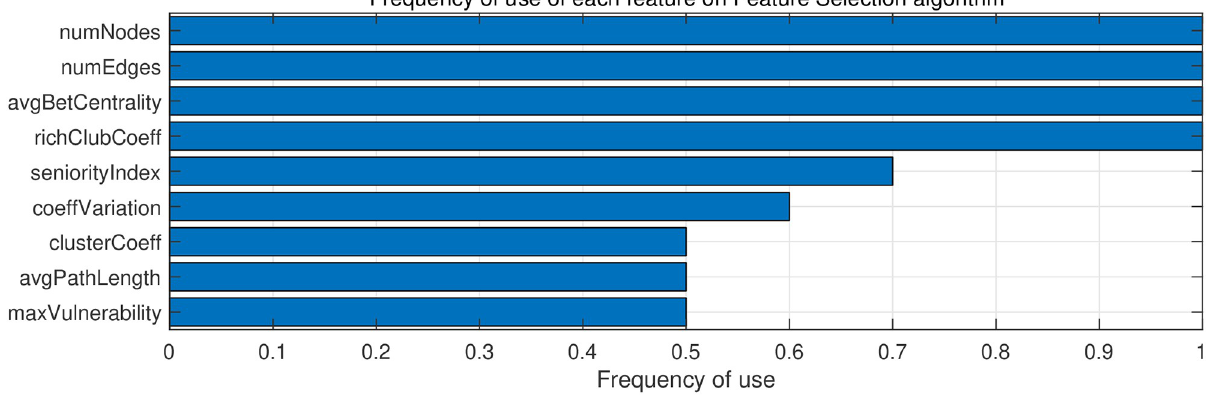
Fig 3. Importance of each feature for the classification of CAPES grade regarding the feature selection